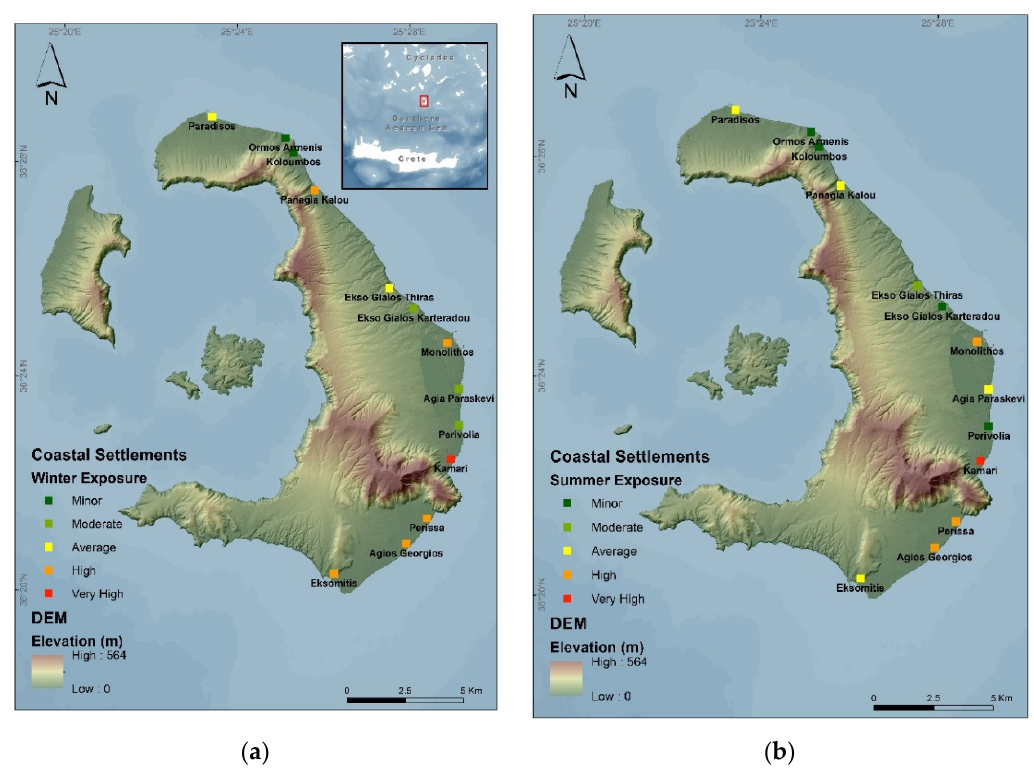
Figure 3. Total Exposure to natural hazards of the coastal settlements of Santorini in: ( a ) winter and ( b ) in